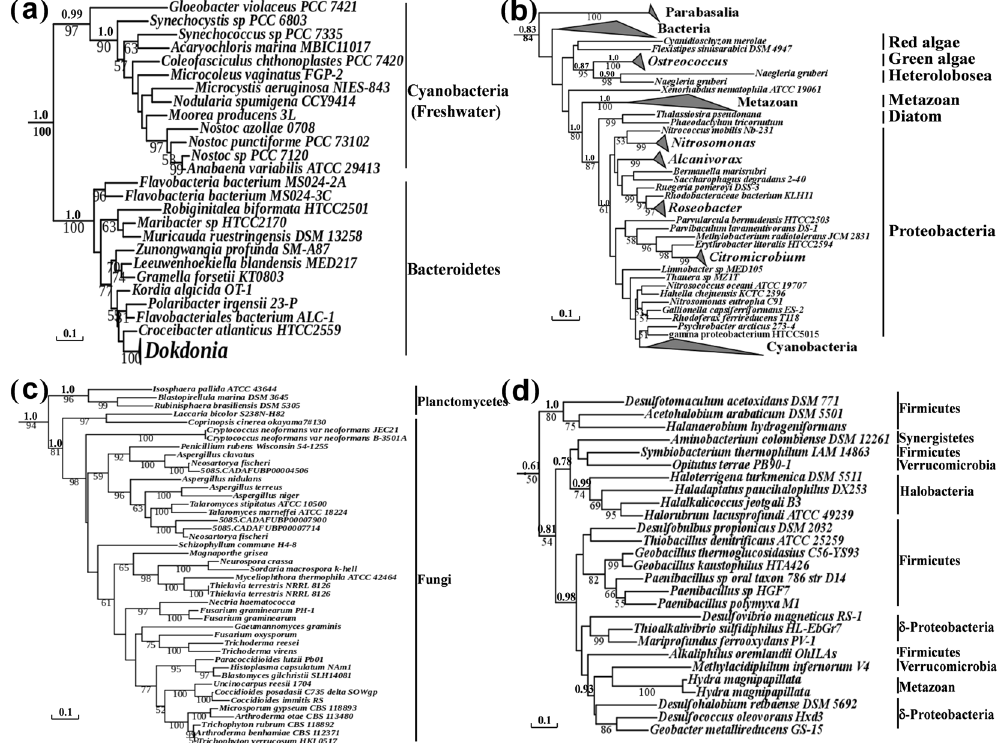
Figure 3. Maximum likelihood tree of ArsM orthologs in different groups. ( a ) Maximum likelihood tree of ArsM orthologs in Group I; ( b ) Maximum likelihood tree of ArsM orthologs in Group III; ( c ) Maximum likelihood tree of ArsM orthologs in Group IV; ( d ) Maximum likelihood tree of ArsM orthologs in Group VI. Maximum likelihood bootstrap support value ( > 50) are indicated below branches. Bayesian posterior probability values of critical bipartition appear above the branch for